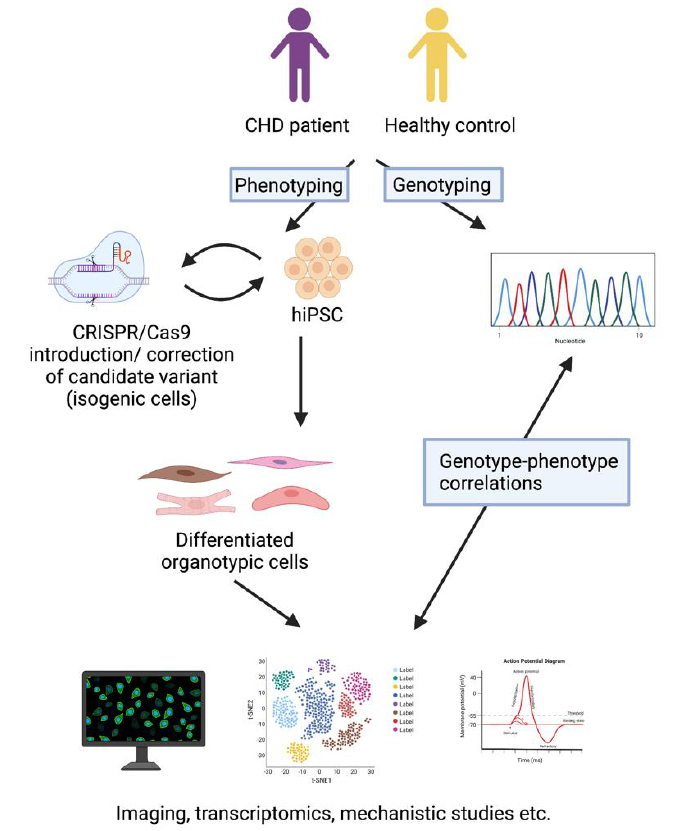
Figure 1. Disease modeling with human induced pluripotent stem cells (hiPSC). HiPSCs are derived from CHD patients and healthy controls. The candidate variant can be corrected with CRISPR-Cas9 technology in patient cells, or it can be introduced to cells from healthy controls. The hiPSCs can be differentiated to organotypic cells, such as cardiomyocytes, endothelial cells, fibroblasts, and smooth muscle cells. The phenotypes of the organotypic hiPSCs with the candidate variant can be compared to those without it, and genotype-phenotype associations can be identified. The figure has been created with BioRender.com.